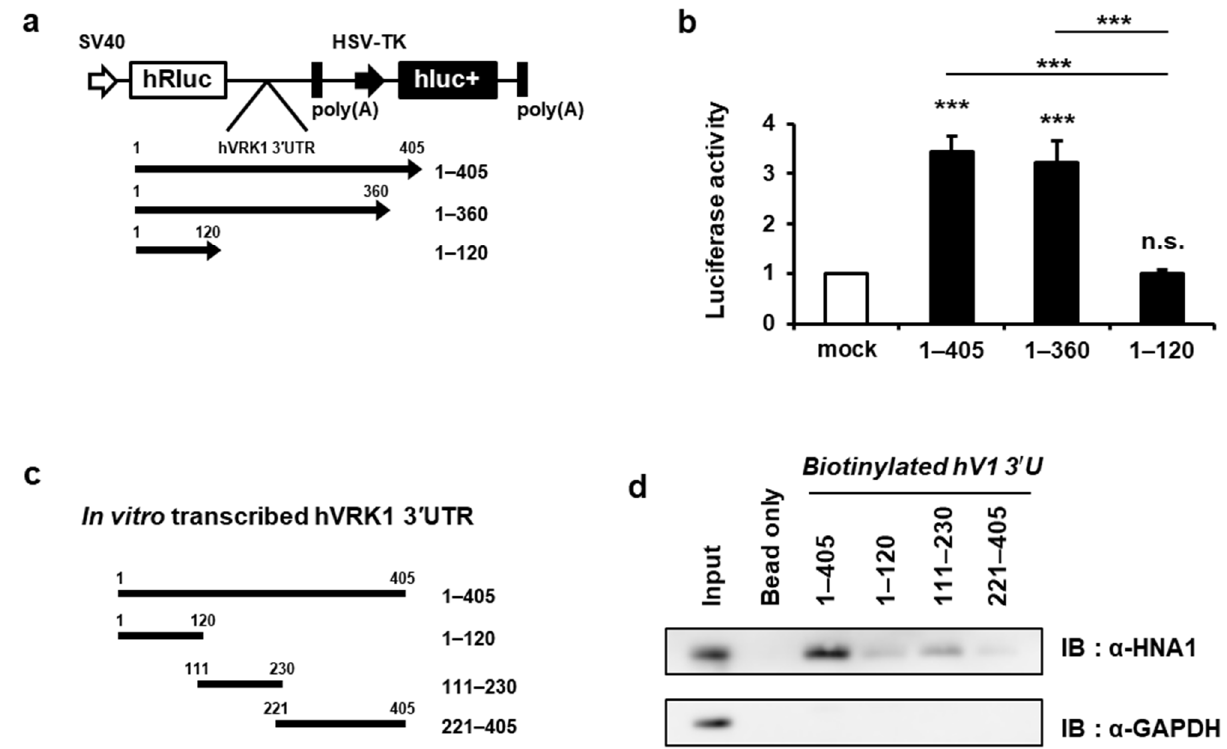
Figure 3. Secondary loop containing AUUUA in VRK1 3 (cid:48) UTR important for VRK1 mRNA translation. ( a ) Schematic diagrams of VRK1 3 (cid:48) UTR deletion constructs are shown. ( b ) Relative luciferase activity in A549 cells transfected with VRK1 3′UTR deleted constructs were determined by luciferase assay (unpaired two-tailed Student’s t -test, n = 4; n.s., not significant; *** p < 0.001). ( c ) Schematic diagrams showing biotinylated RNA fragments spanning from the beginning of 3′UTR of VRK1 to the end, which were used for pull-down. ( d ) Biotinylated RNA fragments were incubated with cytoplasmic lysates from HEK293A cells; after biotinylated RNA fragments were pulled-down using streptavidin beads, the levels of HNRNP A1 bound to the biotinylated RNA segments were detected by immunoblot analysis.